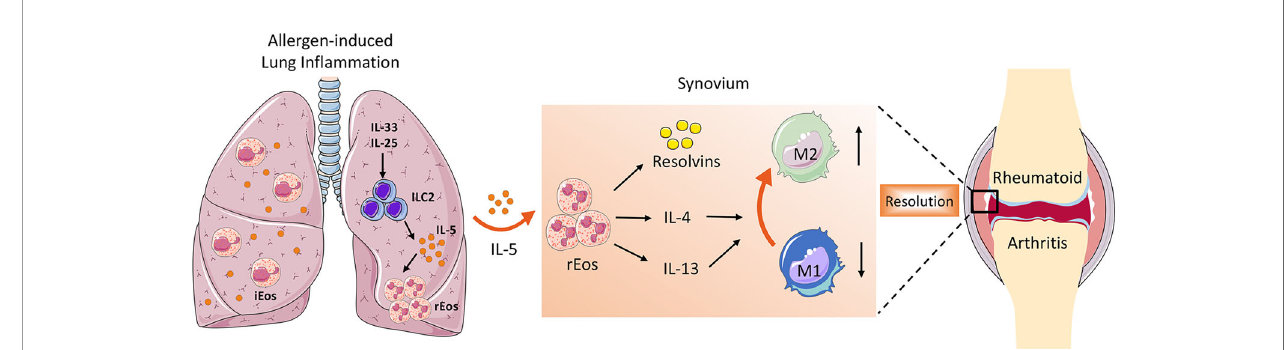
FIGURE 1 | The role of ILC2 – eosinophil – M2 macrophage axis in promoting resolution of arthritis. In allergen-triggered lung in fl ammation, ILC2 was expanded and activated in response to stimulators such as IL-33 and IL-25. Systemically elevated IL-5 secreted by ILC2 drives proliferation and recruitment of rEos into the in fl amed joints, where they produce a variety of lipid mediators and anti-in fl ammatory type 2 cytokines, which facilitate M2 macrophage priming and eventually contribute to the resolution